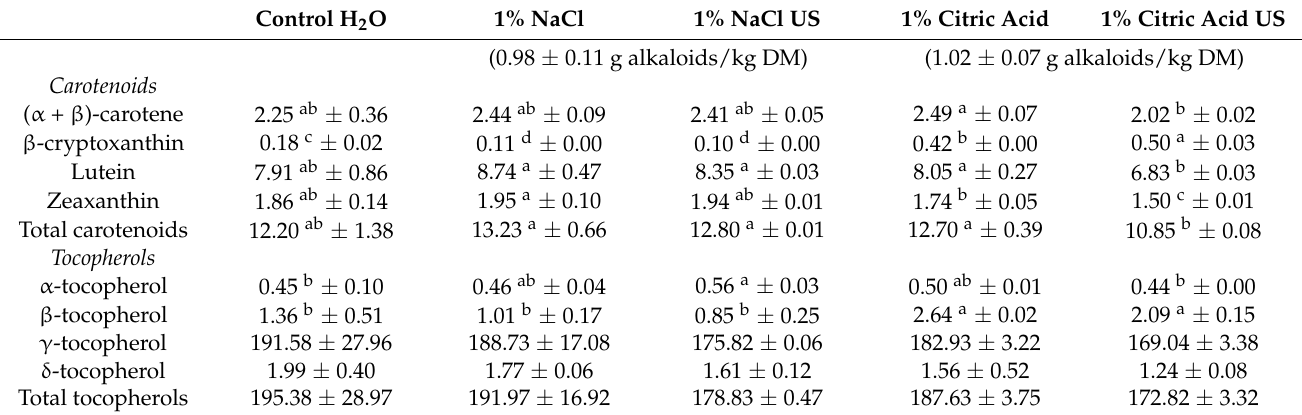
Table 1. Carotenoid and tocopherol content (mg/kg DM; mean ± standard deviation) in Lupinus albus seeds (Lot 1) after debittering by the control method with water (Erba¸s [28], modified by C ó rdova- Ramos et al. [27]) and by the method proposed by Estivi et al. [25], without and with ultrasound (US), and with different solvents (1% NaCl for 45 h or 1% citric acid for 28.5